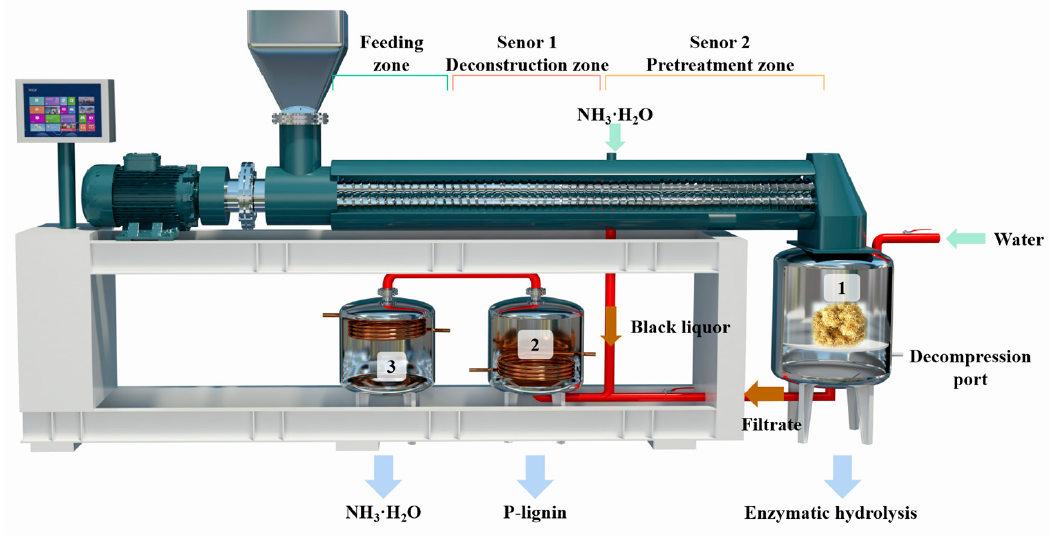
Figure 1. One integration process for the ammonia–mechanical pretreatment of wheat straw: 1. seal pot for heat preservation; 2. evaporation chambers; 3. condensation chambers.